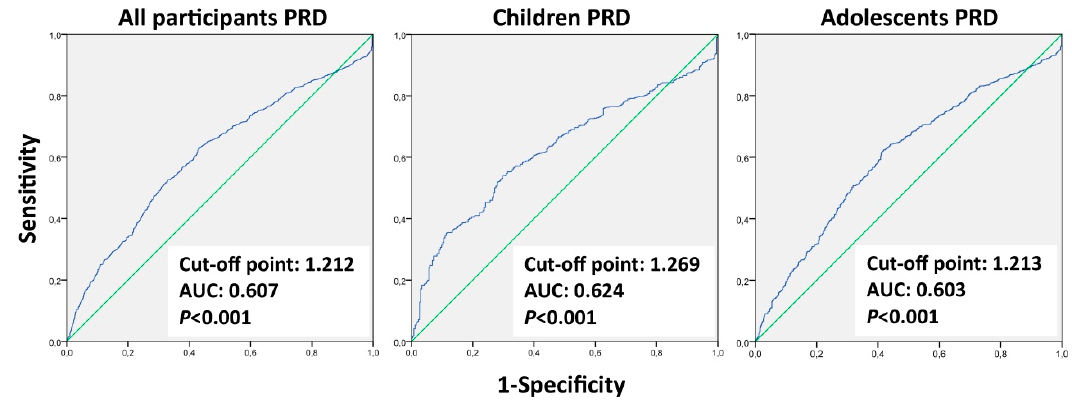
Figure 3. Receiver operating characteristic (ROC) curves of ACS by PRD measure separately by age groups. Note: PRD = Pedestrian route directness; AUC = Area under the curve.